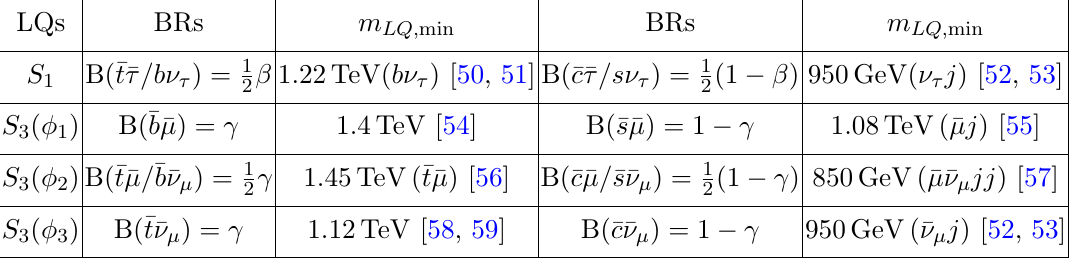
Table 1 . Decay branching ratios of leptoquarks, and LHC bounds on leptoquark masses. Here, ) and (cid:13) (cid:17) (cid:20) 2 = ( (cid:20) 2 + (cid:20) 2 ). Most LHC bounds are given for B = 1, except in (cid:12) (cid:17) (cid:21) 2 = ( (cid:21) 2 + (cid:21) 2 33 33 23 32 32 22 ref. [57] where B ((cid:22) c (cid:22) (cid:22) ) = B ((cid:22) s (cid:22) (cid:23) (cid:22) ) = 0 : 5 was